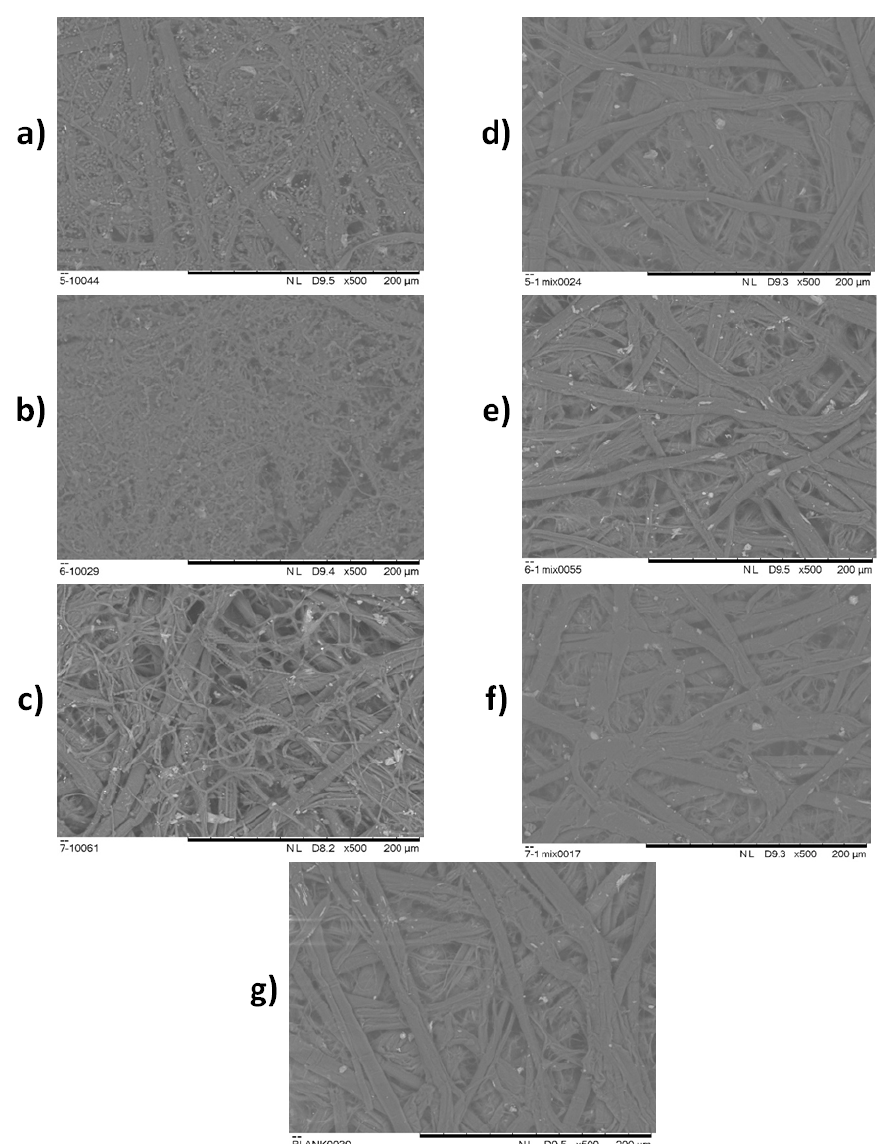
Figure 2. SEM micrographs for: ( a – c ) non treated samples C. cladosporoides (5/1), A. fumigatus (6/1), and P. chrysogenum (7/1), respectively; ( d – f ) treated samples C. cladosporoides (5/1) mix, A. fumigatus (6/1) mix and P. chrysogenum (7/1) mix, respectively; ( g ) blank historical paper